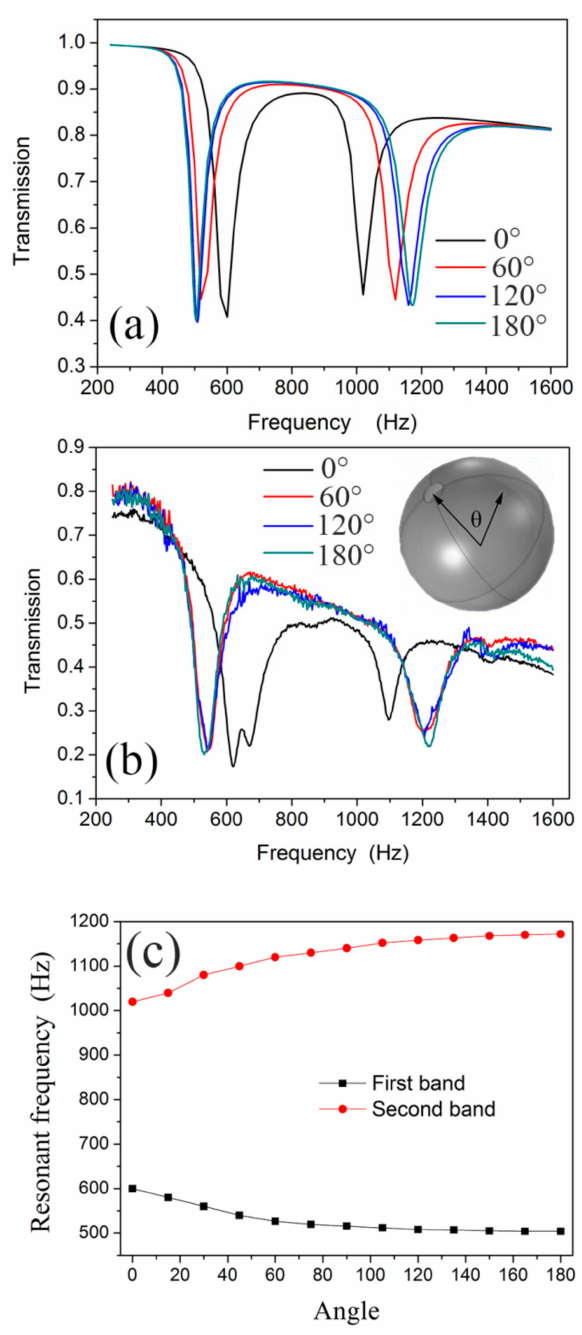
Figure 6. ( a ) The simulated and ( b ) experimental transmission with the directional angle θ of the split holes for NSHS-AMM; ( c ) the relation between the simulated dips frequencies and directional angle θ